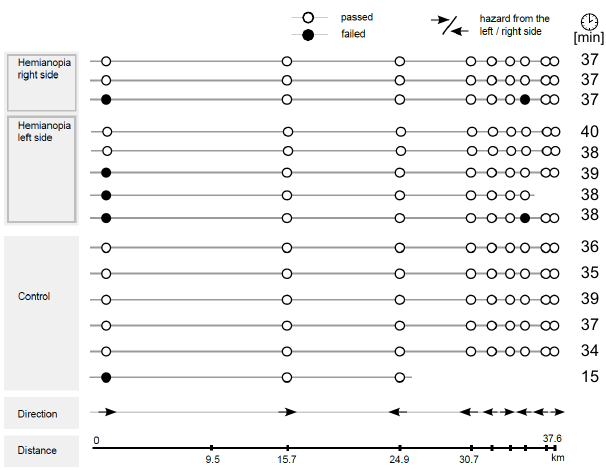
Figure 3 . Driving test result for each participant (rows) and each hazardous situation (columns). The last column shows the time each participant needed to complete the driving test. Arrows represent the direction from which the traffic hazard is approaching. Cases associated with a driving test failure are marked in black. Subjects are divided into the follow- ing subgroups: HC: control group, HR: HVFD patients with a right-sided visual field defect, HL: HVFD patients with a left-sided